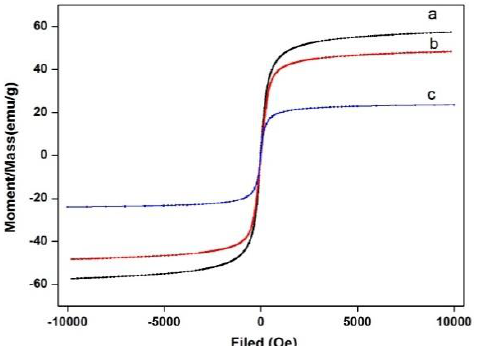
Figure 4. The magnetic hysteresis loops of ( a ) FeO x @COOH magnetic nanoparticles, ( b ) FeO x / ZnS NPs, and ( c ) FeO x /ZnS@MIPs.